Question: According to this chart, does the measure grow or shrink?
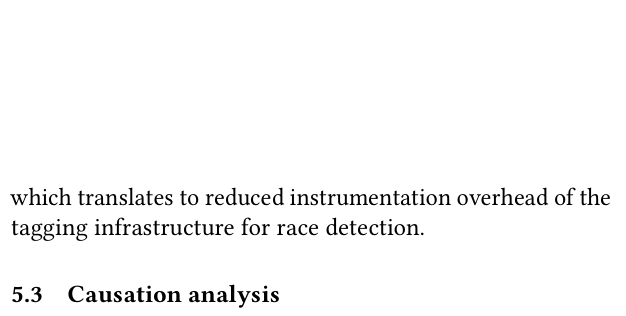
Answer: increasing